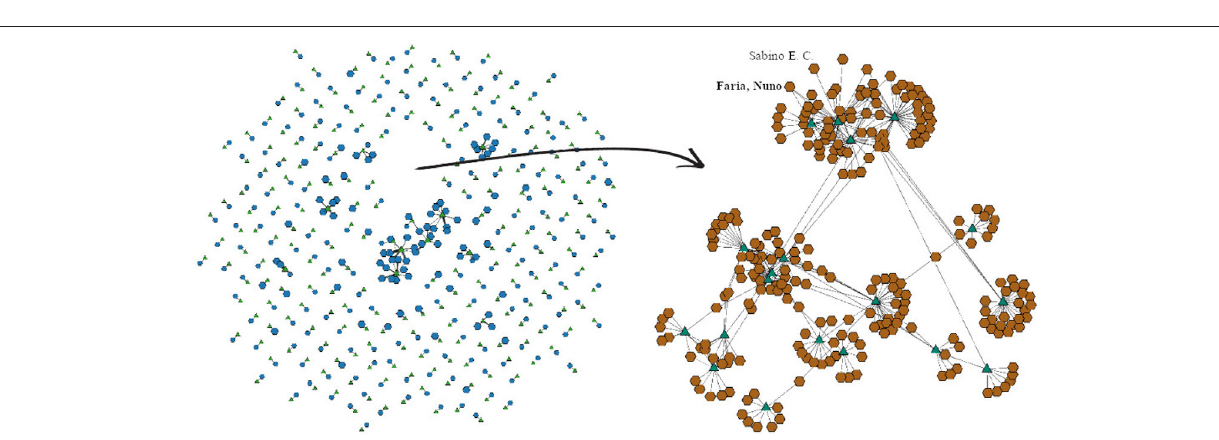
FIGURE 11 | Further exploratory investigation of a selected group, departing from the coarsest network. The smaller central group in Figure 10B has been isolated and locally expanded back to level 0, for observation of its detailed